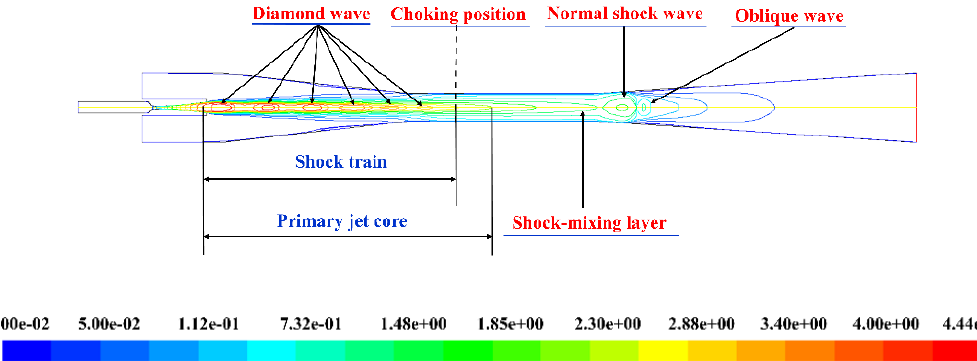
Figure 5. Fluid flow structure inside the ejector.